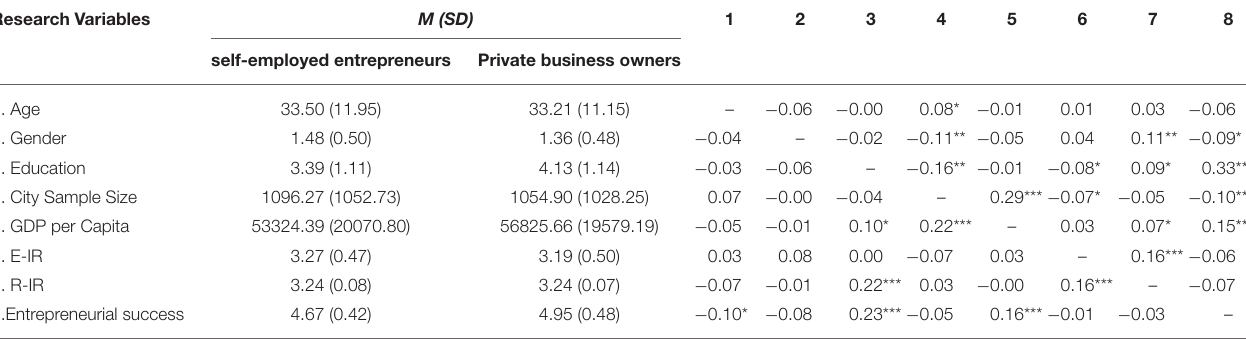
TABLE 1 | The descriptive statistics and correlations for the two samples. Research Variables